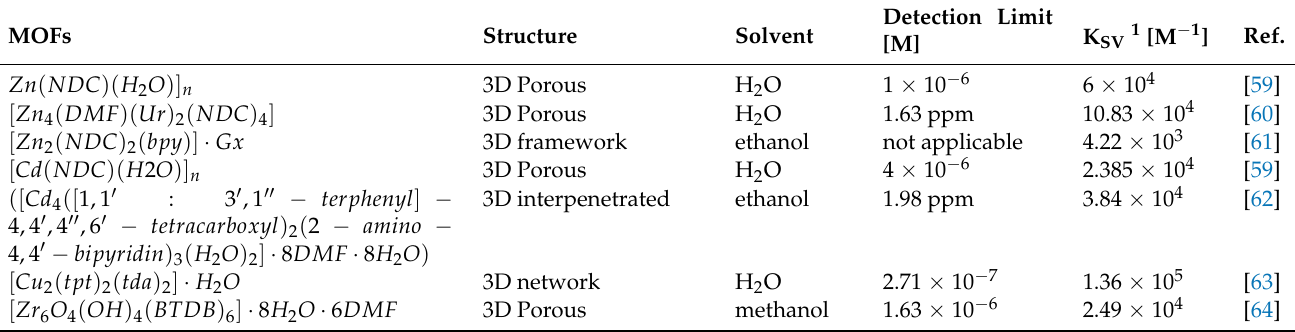
Table 2. Summary of d-block metal–organic frameworks used for the detection of picric acid. MOFs Structure